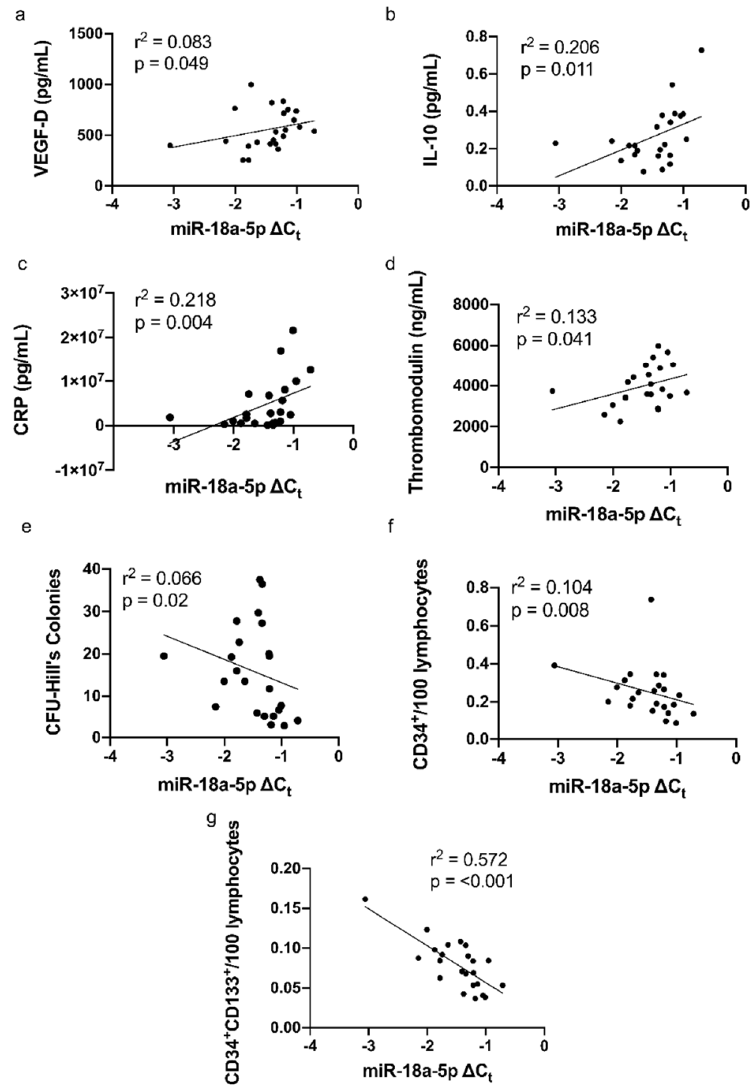
Figure 4. Correlation between miR-18a-5p expression in CFU-Hill’s colonies with the levels of ( a ) VEGF-D (r 2 = 0.083, p = 0.049), ( b ) IL-10 (r 2 = 0.206, p = 0.011), ( c ) CRP (r 2 = 0.218, p = 0.004), ( d ) thrombomodulin (r 2 = 0.133, p = 0.041) in the plasma, ( e ) CFU-Hill’s colonies per well (r 2 = 0.066, p = 0.02), ( f ) CD34 + /100 lymphocytes (r 2 = 0.104, p = 0.008), and ( g ) CD34 + CD133 + /100 lymphocytes (r 2 = 0.572, p < 0.001). Linear regression analysis was performed to assess the correlation. VEGF: vascular endothelial growth factor; IL: interleukin; CRP: C − reactive protein; CFU: colony-forming unit; CD: a cluster of differentiation.